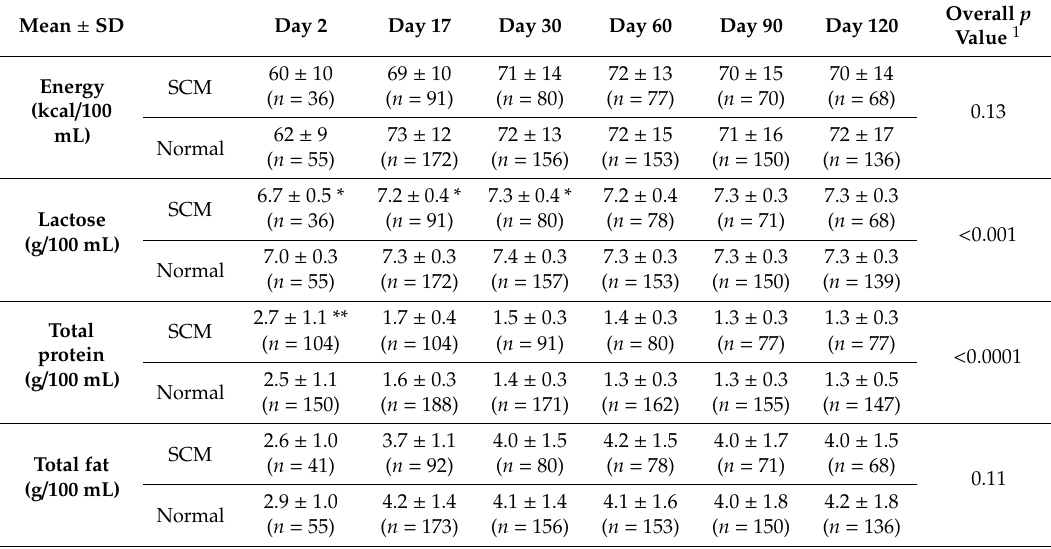
1 The macronutrient composition of HM across lactation was analyzed by using linear mixed model with milk concentration (of a particular nutrient) as dependent variable with the age of infant, SCM status, interaction between the age and the SCM status, the country of origin, the mode of delivery, and the gestational age of the infant at birth as explanatory variables. * Statistical significance of the di ff erence between mothers with SCM and without SCM for